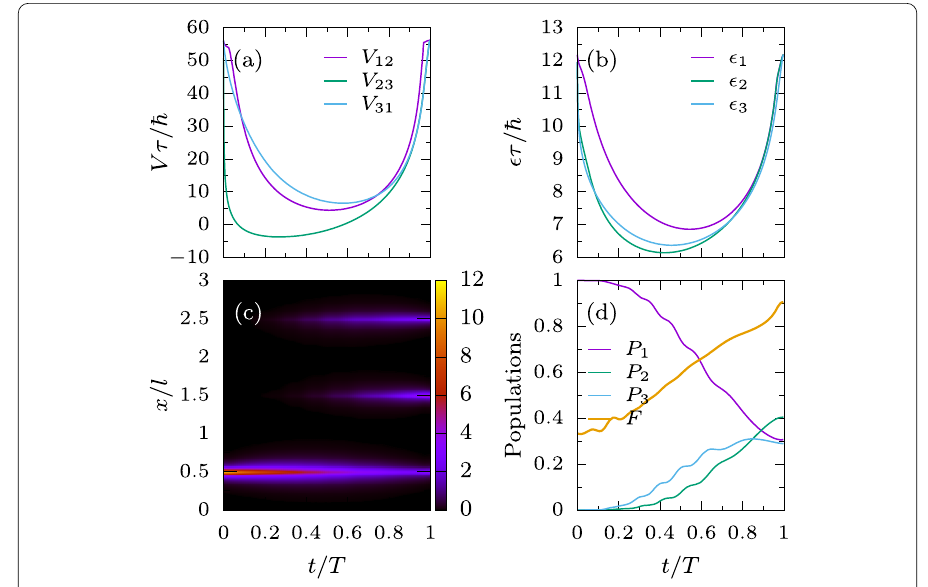
Figure 7 Same as Figure 6(a)-(d) but for the spatial non-adiabatic superposition scheme given in Eq. (31) in the continuum model. T / τ = 400. F = |(cid:10) ψ target | ψ ( t ) (cid:5)| 2 is the fidelity of the